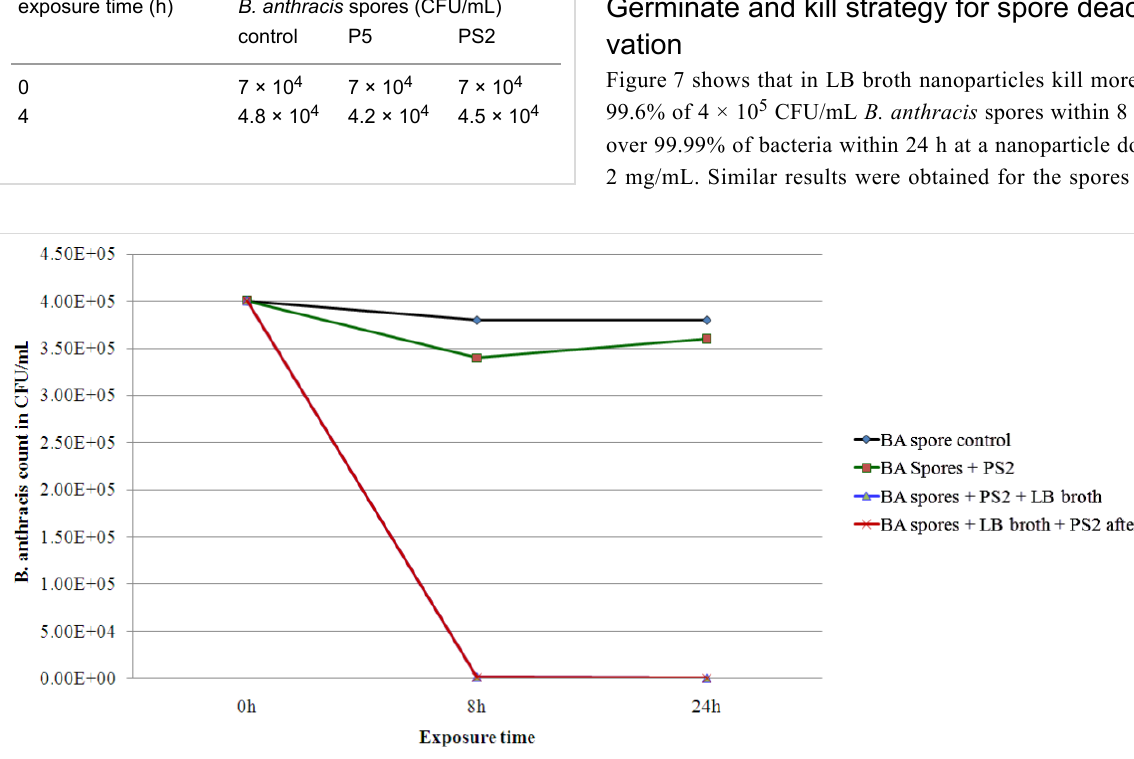
Table 2: Antibacterial activity of multi-armed copper oxide nanoparti- cles (P5) and CuO nanorods (PS2) against B. anthracis spores with 10 mg/mL of CuO-NPs in distilled